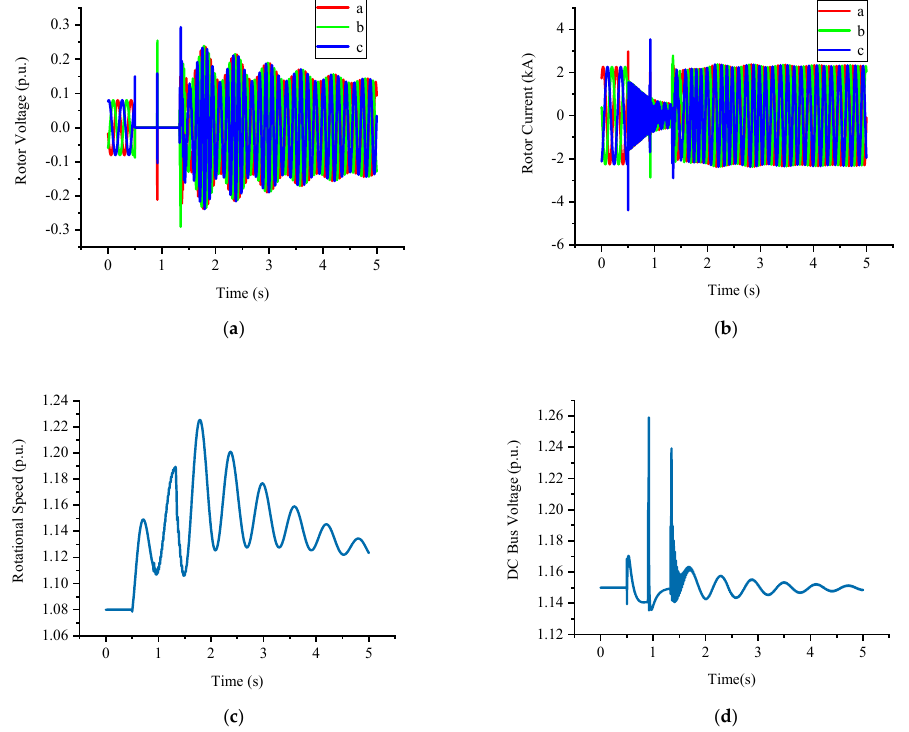
Figure 15. Double-fed power generation system. ( a ) Rotor voltage; ( b ) rotor current; ( c ) rotational speed; ( d ) DC bus voltage.